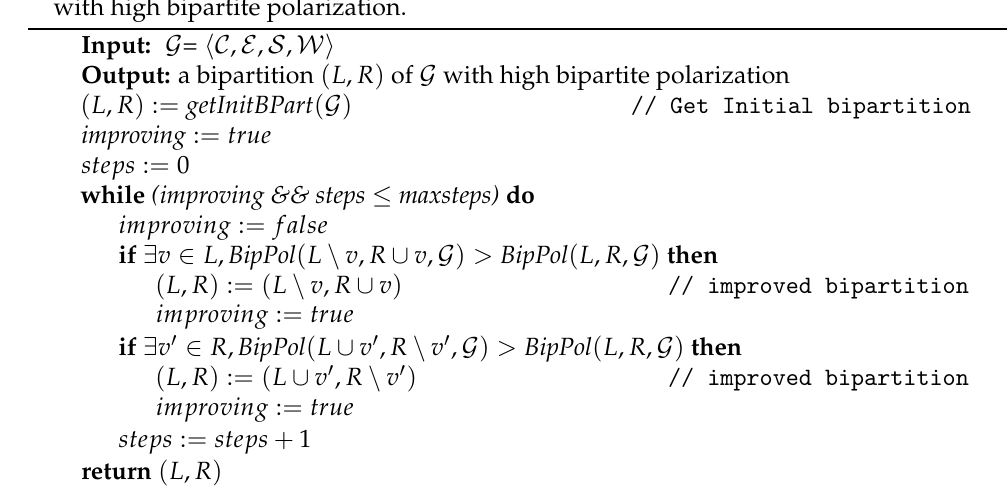
Algorithm 1: Finding a local optimal solution for a bipartition of G = (cid:104)C , E , S , W(cid:105) with high bipartite